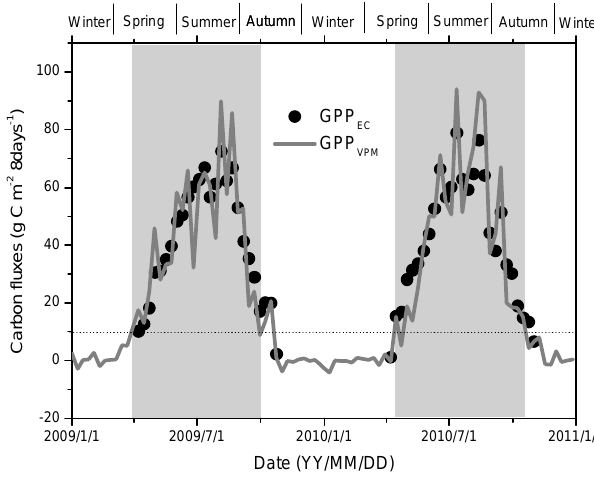
Figure 7. Comparisons of the seasonal dynamics between the estimated gross primary production from EC tower (GPP EC ) and simulated gross primary production by VPM (GPP VPM ) during 2009–2010. Spring: March to May; Summer: June to August; Autumn: September to November; and, Winter: December to February.